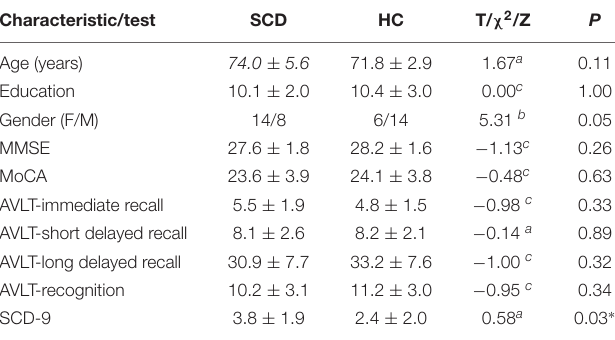
TABLE 1 | Demographics and clinical characteristics of patients with SCD and HC.